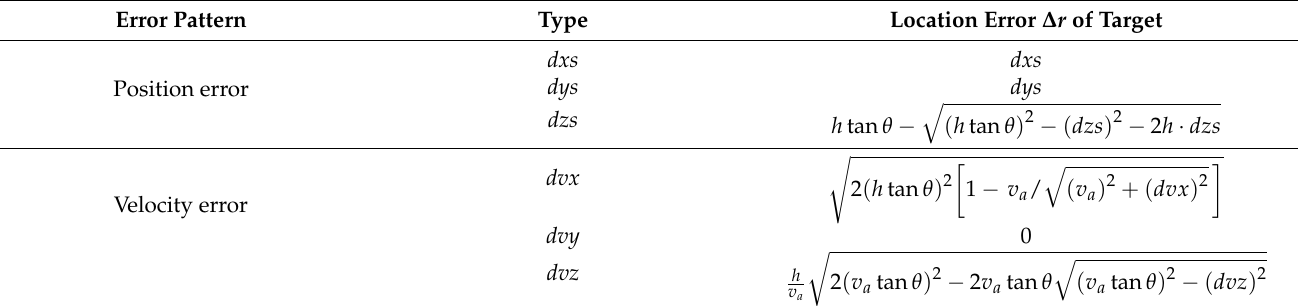
Table 1. Analytical expression of single-view airborne SAR positioning error.